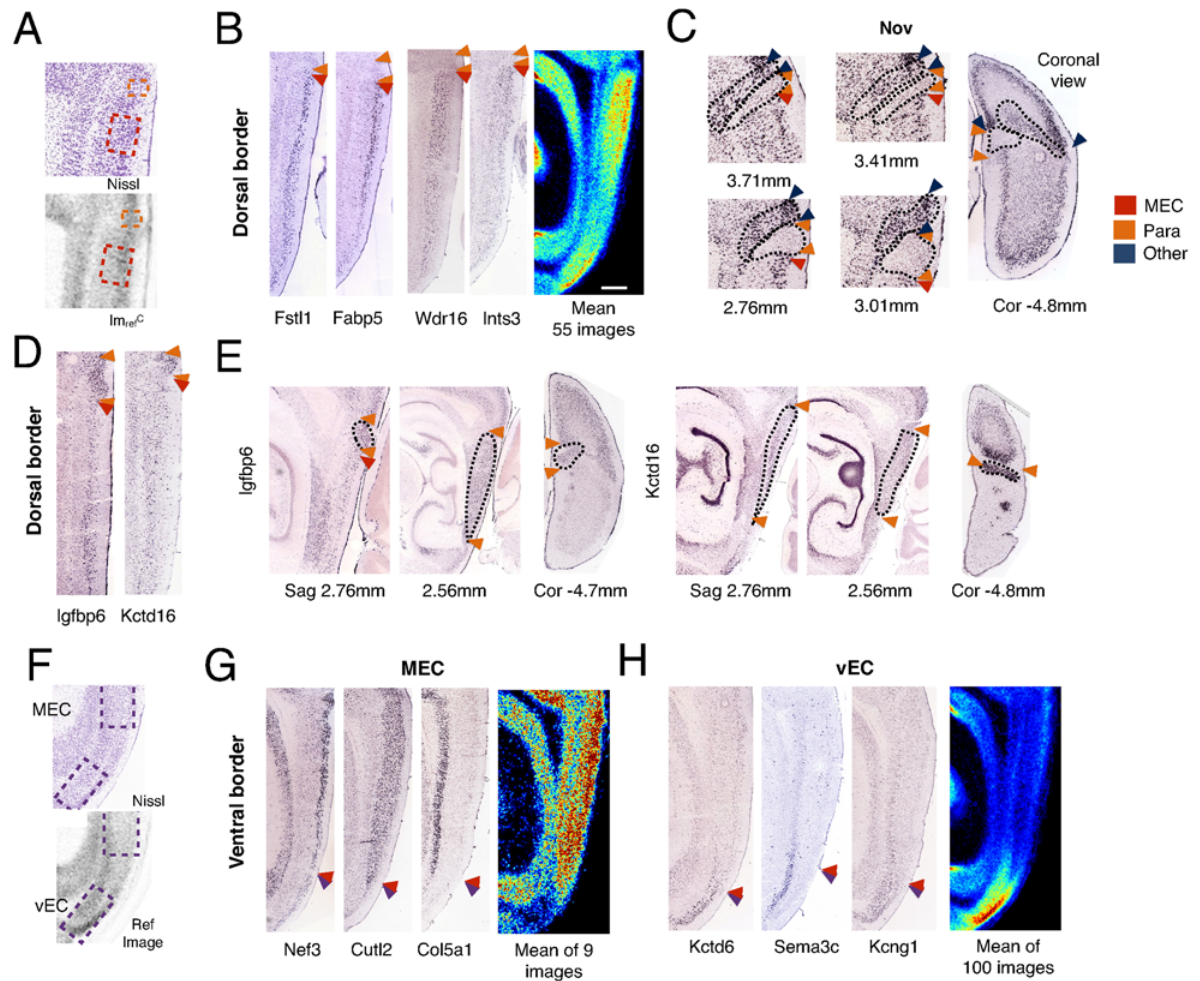
Figure 3. Differential gene expression defines the borders of MEC with neighboring regions. (A) Boxes indicate the dorsal (orange) and ventral (red) regions from which mean pixel intensities (mINT) were extracted for identification of genes defining the dorsal border of the MEC. (B) Example cropped ISH images downloaded from the ABA API are shown (left) adjacent to mean expression pattern for genes expressed in MEC but not the wedge-shaped region dorsal to MEC (right). Arrows indicate regional borders. (C) Raw ISH images show the dorsal border of MEC layer II marked out by the gene Nov at different medio-lateral positions (left) and in the coronal plane (right). Values in mm indicate distance from Bregma. (D) Example cropped ISH images downloaded from the ABA API are shown for genes expressed in the wedge-shaped region dorsal to MEC but not the most dorsal MEC region. (E) Raw ISH sagittal (Sag) and coronal (Cor) images from the ABA indicate the continuity of the wedge-shaped region with the more medial parasubicular region for the genes Igfbp6 and Kctd16 . (F) Boxes highlighting regions used to identify the ventral border of the MEC. See (A). (G-H) Example cropped ISH images downloaded from the ABA API (see Materials and Methods) are shown adjacent to images of the mean expression pattern for genes expressed in MEC but not the more ventral region (G), or in the ventral region but not MEC (H).